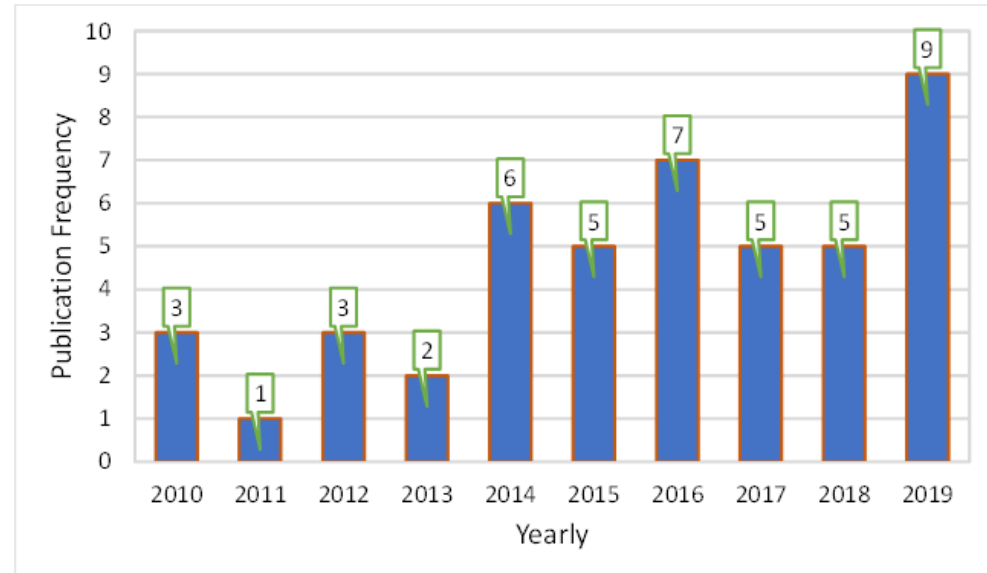
Figure 2. Yearly distribution of publications for the proposed study.